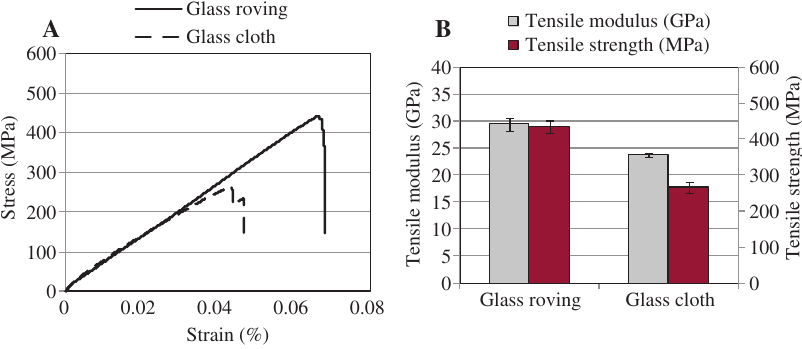
Figure 4 Cross-sectional photographs of as-fabricated composites and schematic drawings: (A and B) glass roving and (C and D) glass cloth.